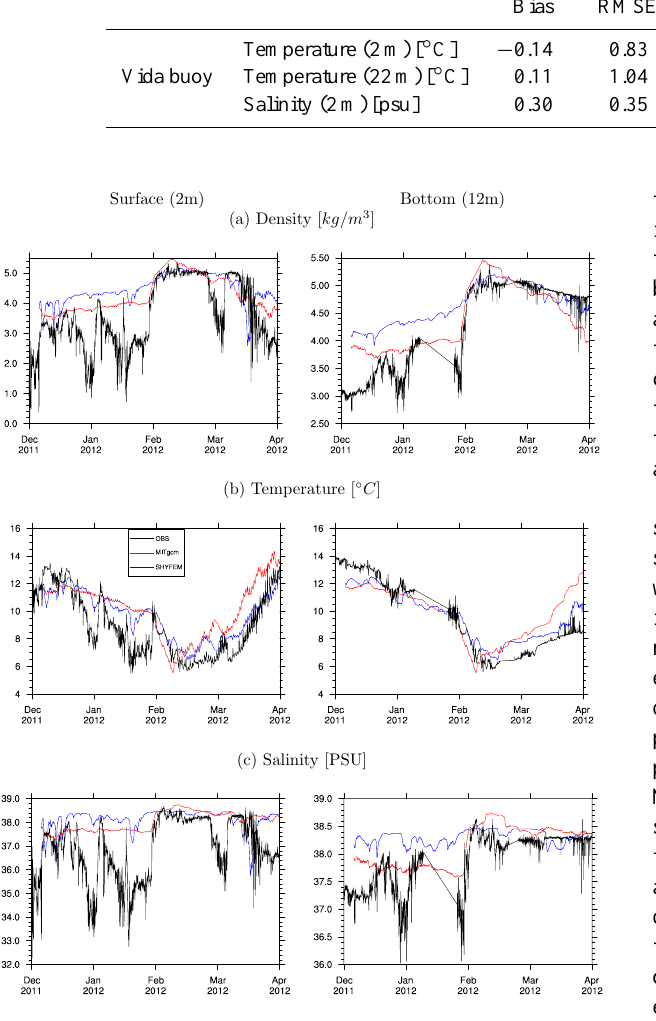
Figure 4. Timeseries of surface (solid) and bottom (dashed) (a) den- sity anomaly, (b) temperature, and (c) salinity for SHYFEM (blue), MITgcm (red), and the CNR Platform observations (black). Note there is a gap in the data for the bottom observations between the 8 and 25